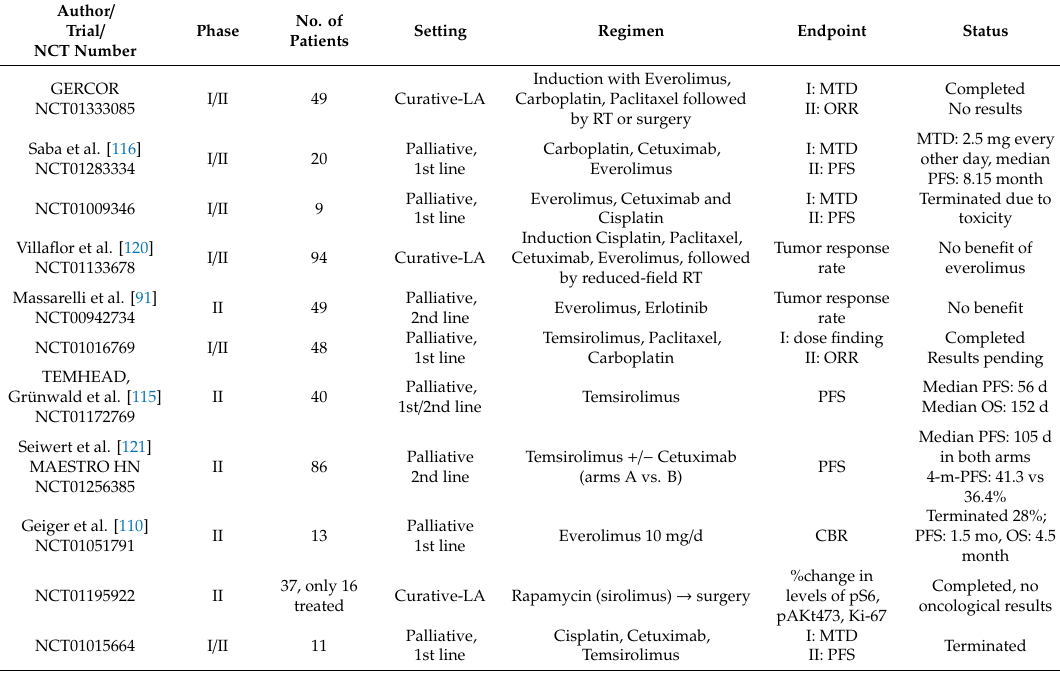
Table 3. Overview of selected trials introducing mTOR inhibitors for head and neck